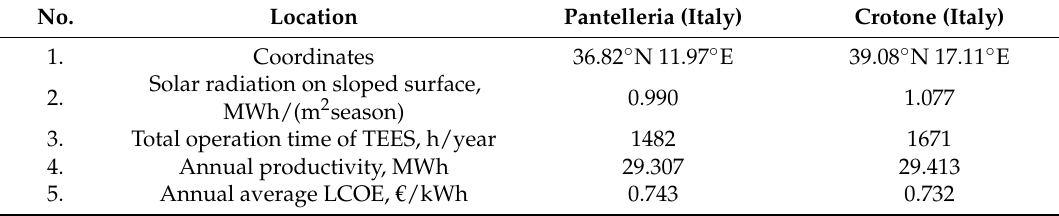
Table 10. Annual operational details for TEES systems operated in Pantelleria and